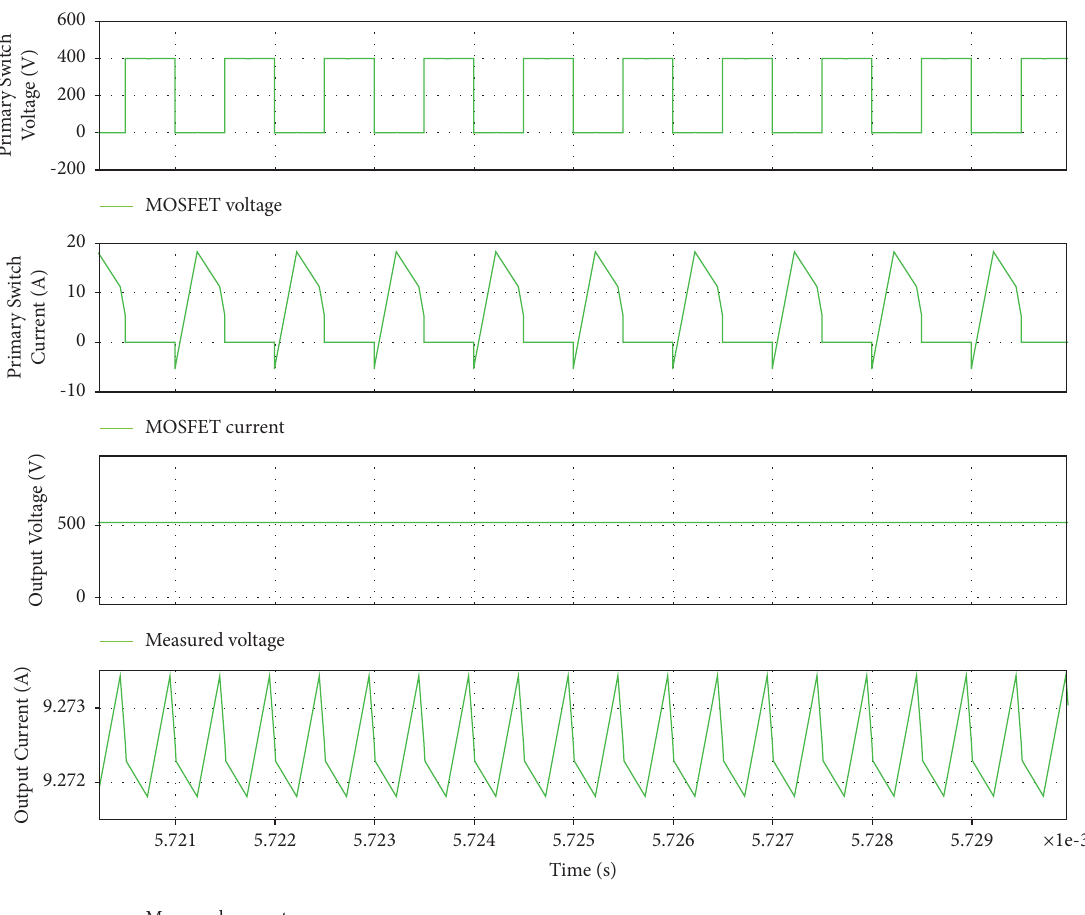
Figure 13: Simulated waveforms of the proposed converter with planar SiC